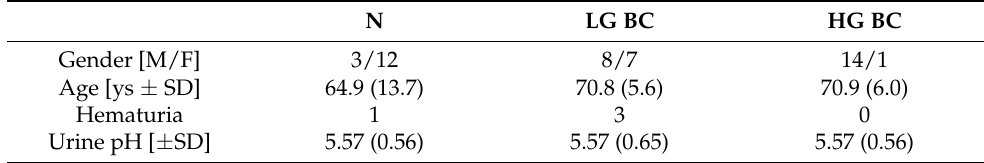
Table 1. Clinical profile of the investigated